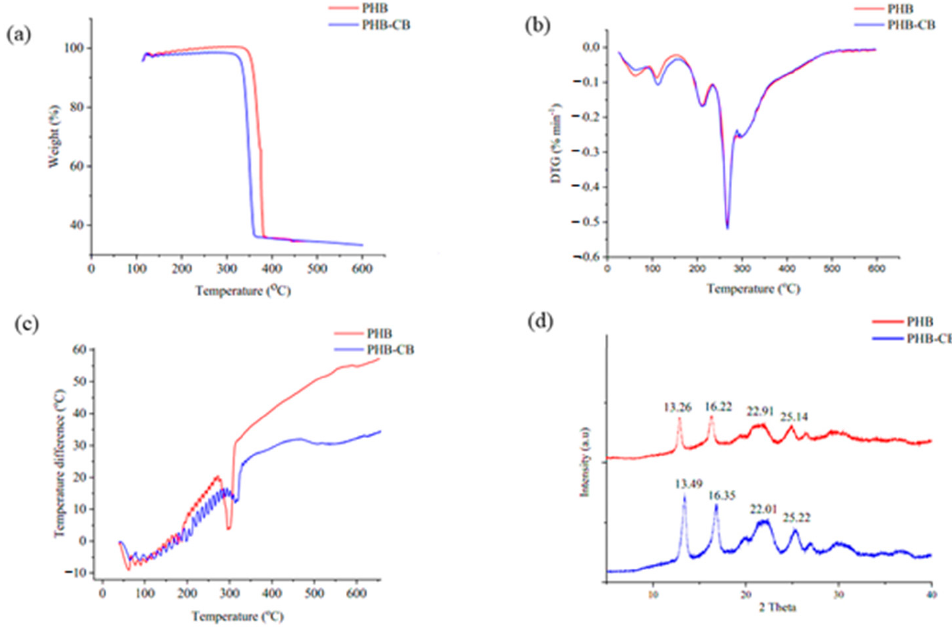
Figure 6. Characterization of PHB and PHB-CB demonstrating ( a ) TGA, ( b ) DTG, ( c ) DTA, and ( d ) XRD.